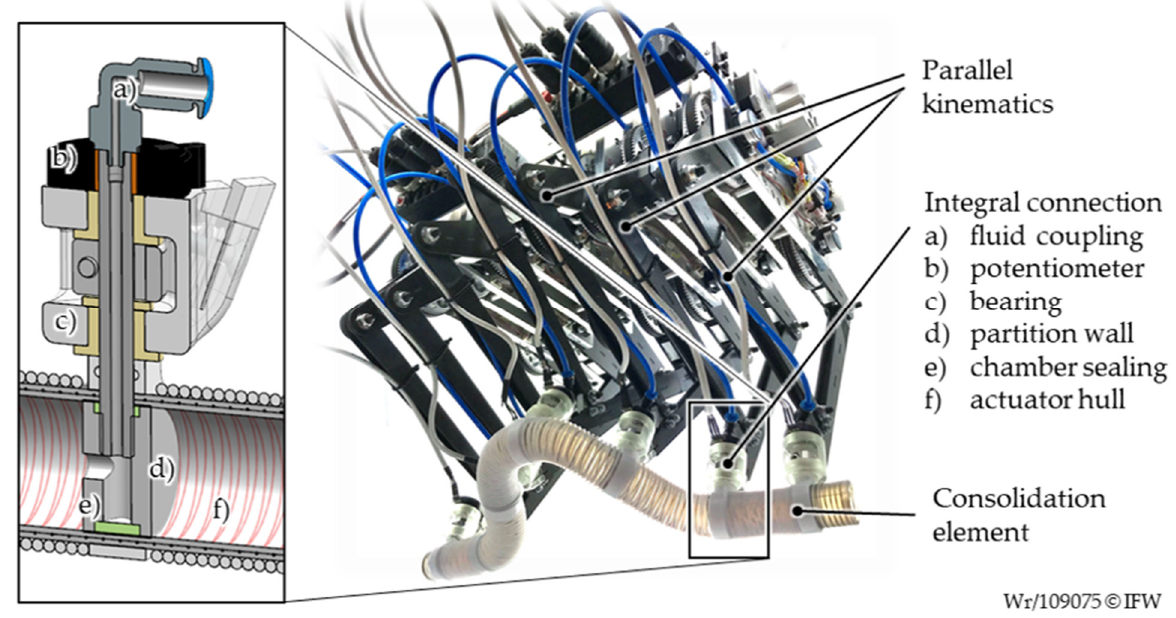
Figure 10. Shape replicating draping unit with a sectional view of the connection.